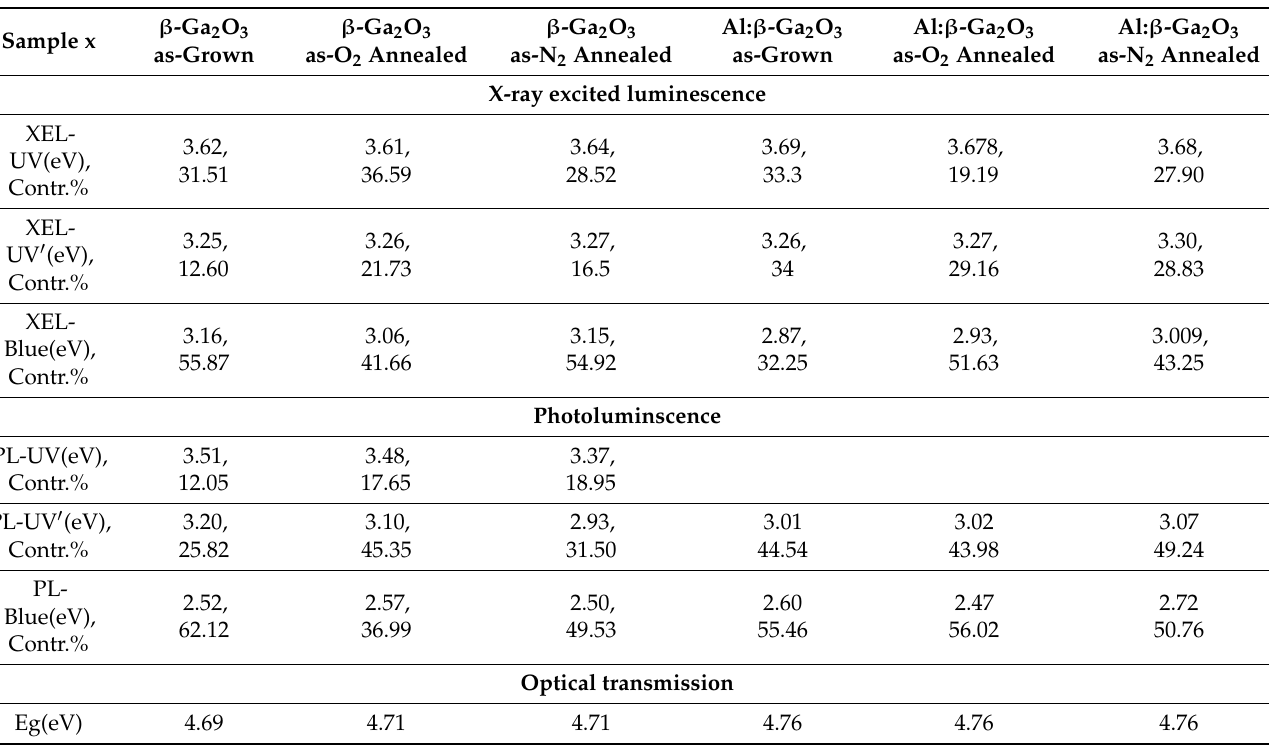
Figure 1. Transmittance of undoped β -Ga 2 O 3 and 2.5 mole% Al-doped β -Ga 2 O 3 single crystals as-grown and as-annealed process. Table 1. XEL (X-ray excited luminescence), PL (photoluminescence), energy gap and PL decay time constants of undoped and 2.5 mole% Al-doped β -Ga 2 O 3 (Ex. 270 nm, Em. 380